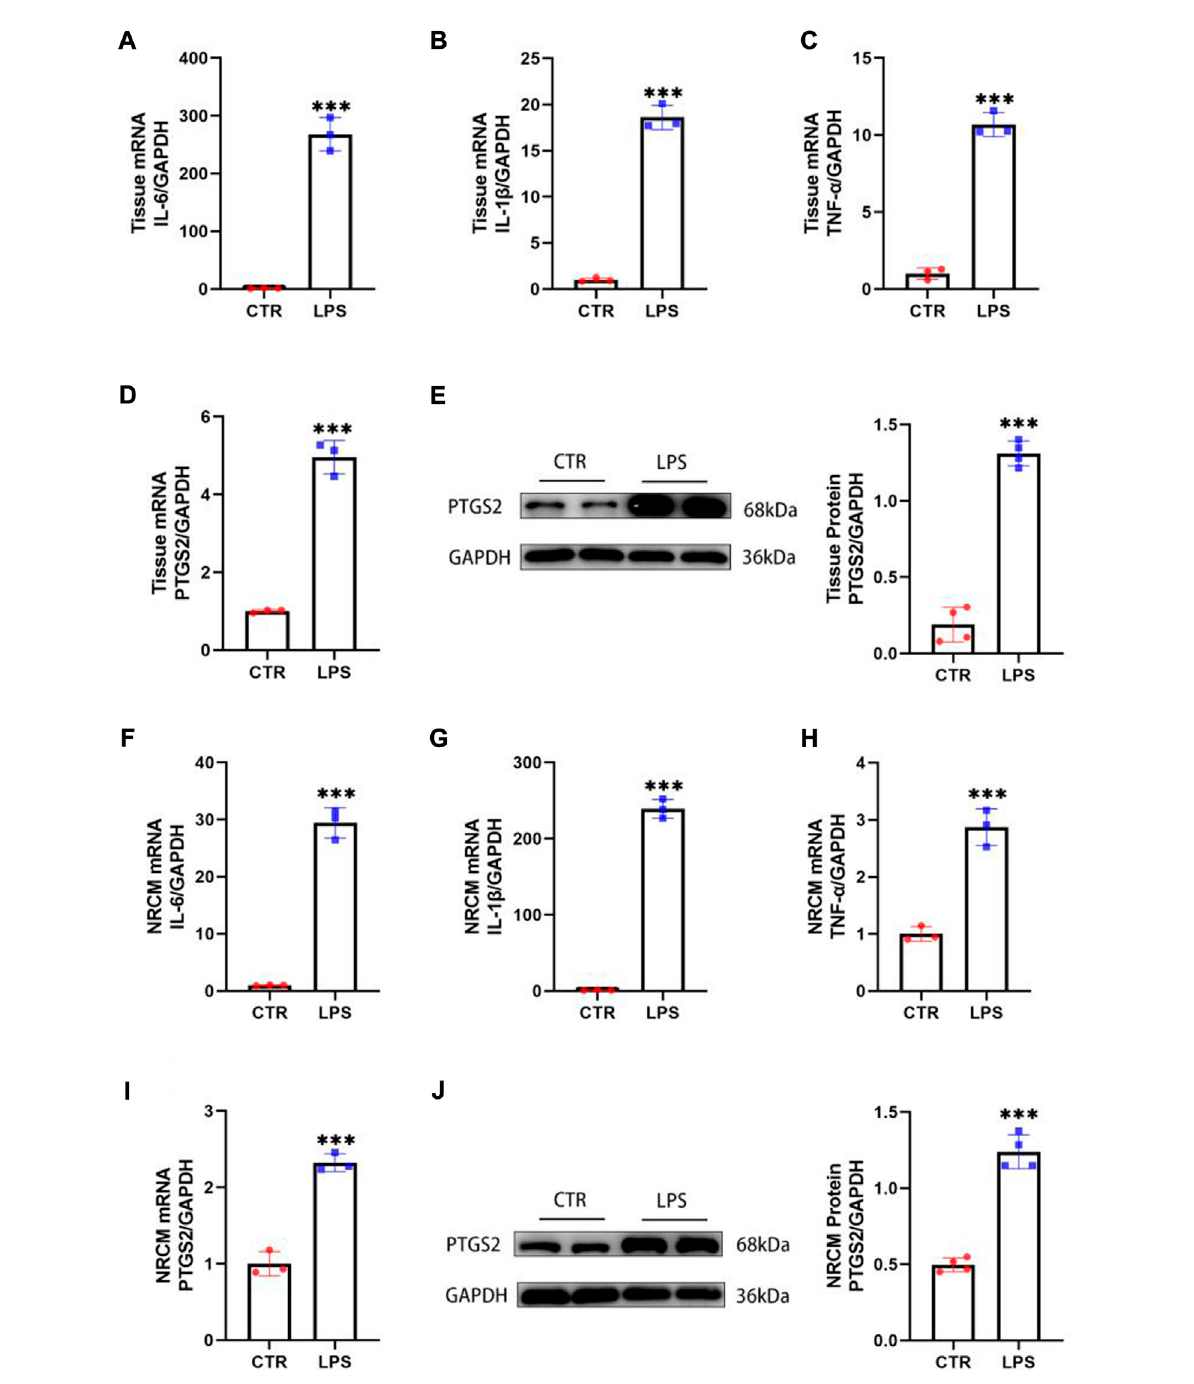
LPSactivatedin fl ammationandferroptosisintheheart. (A – D) ThemRNAexpressionlevelsofIL-6,IL-1 β ,TNF- α andPTGS2intheheartsofmice treatedwithLPS( n =3). (E) TheproteinlevelsofPTGS2intissues( n =4). (F – I) ThemRNAexpressionlevelsofIL-6,IL-1 β ,TNF- α andPTGS2inNRCMs treated with LPS ( n = 3). (J) The protein levels of PTGS2 in tissues ( n = 4). *** indicates p <